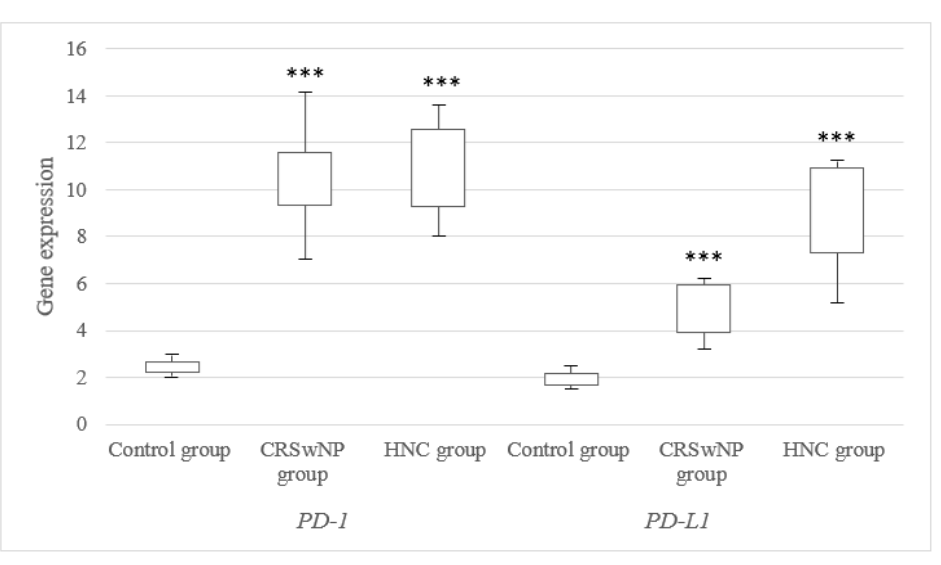
Figure 1. mRNA expression level of the PD-1 and PD-L1 genes in the examined patients with CRSwNP and HNC. *** p < 0.001 versus control group.